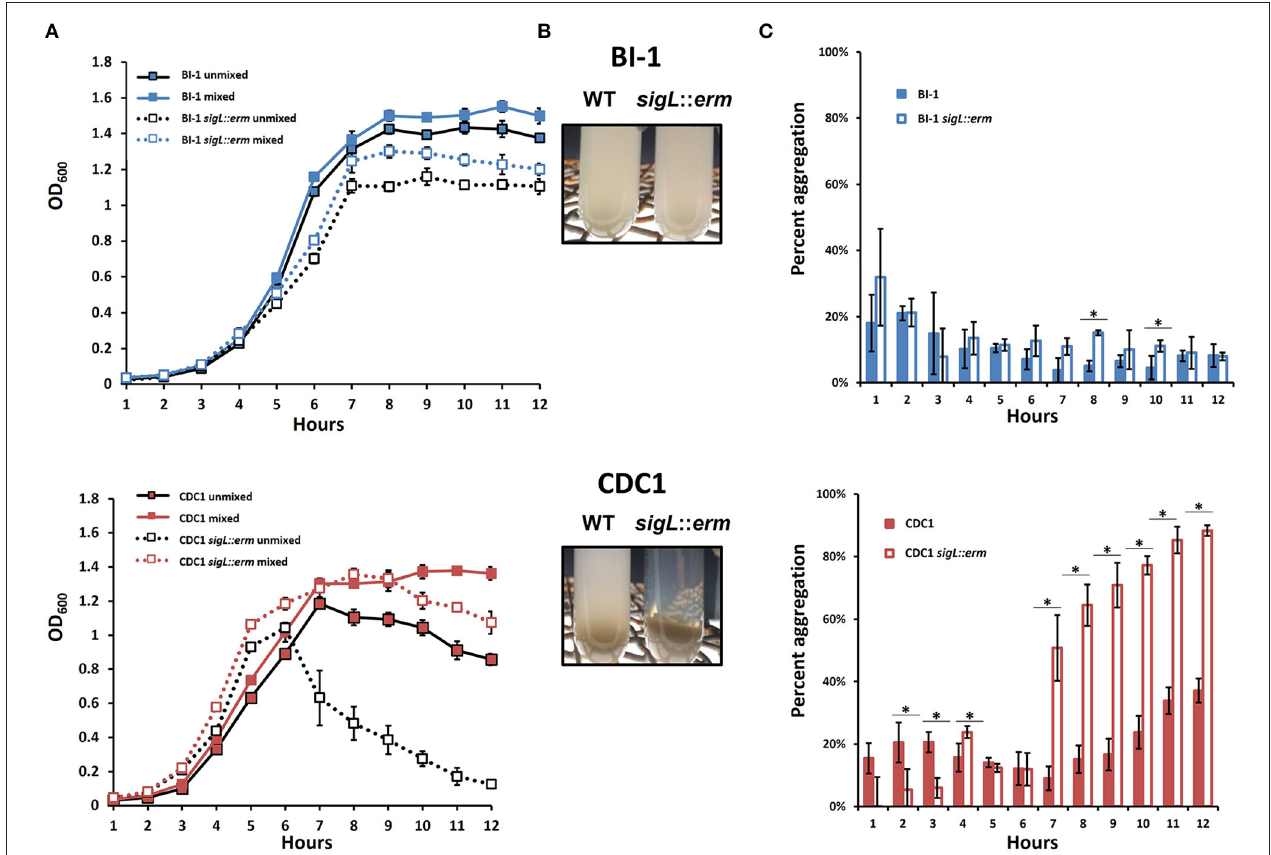
FIGURE 5 | Aggregation of C. difficile strains and respective sigL::erm mutants differs between BI-1 and CDC1. (A) OD 600 values of the top 1ml of culture (unmixed) and a replicate vortexed culture sample (mixed) were read hourly to determine sedimentation curves. (B) Visualization of aggregation in BI-1 (top) and CDC1 (bottom) WT and sigL::erm strains. (C) Percent aggregation of C. difficile strains and respective sigL::erm mutants, calculated as the difference in OD 600 values between the whole (mixed) culture and top 1ml (unmixed) culture, as a percentage of the mixed culture OD 600 value. Cultures were grown in biological triplicate. WT and sigL::erm pairs were compared at each time point using Student’s t -test. * p < 0.05.